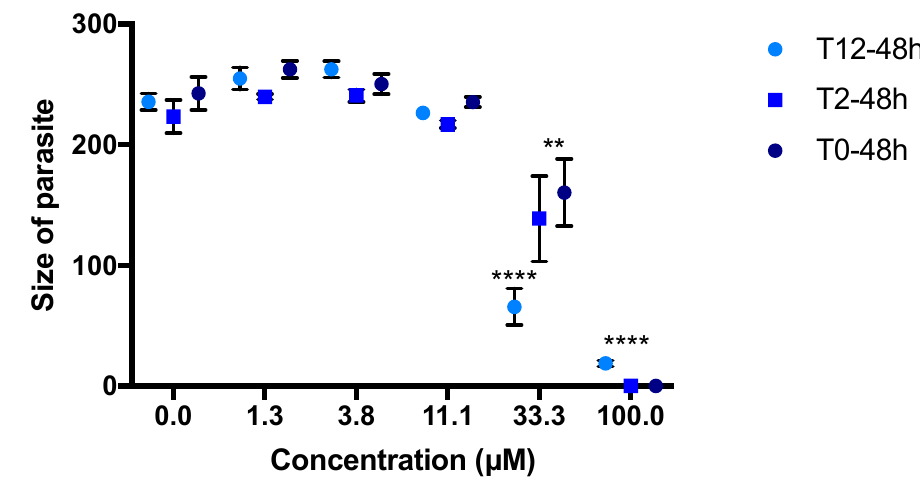
Figure A2. MB shows weak inhibition of liver stage development in vitro. MB activity against P. berghei liver stages was investigated at concentrations ranging from 1.25 to 100 µM. MB was added simultaneously to the hepatocyte invasion (0 h) or 2 h and 12 h pi. Activity is presented as the size of schizonts counted (blue bars = EEF size). Data are means and SDs of triplicate measurements from one representative experiment. The black lines represent the mean and standard deviation. ** p < 0.01; **** p = 0.0001 when compared to control by t -test.